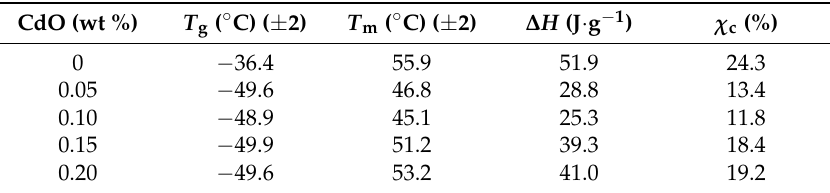
Table 1. Comparison of thermal parameters obtained from differential scanning calorimetry (glass transition temperature, T g , melting temperature T m , enthalpy change ∆ H , and fraction of crystalline region in the polymer referred to as crystallinity χ c ) of PEO-LiI-CdO composite polymer electrolytes (CPEs). Adapted from Karmakar et al. [63]. CdO (wt %) T g ( ◦ C) ( ± 2) T m ( ◦ C) ( ± 2) ∆ H (J · g − 1 ) χ c